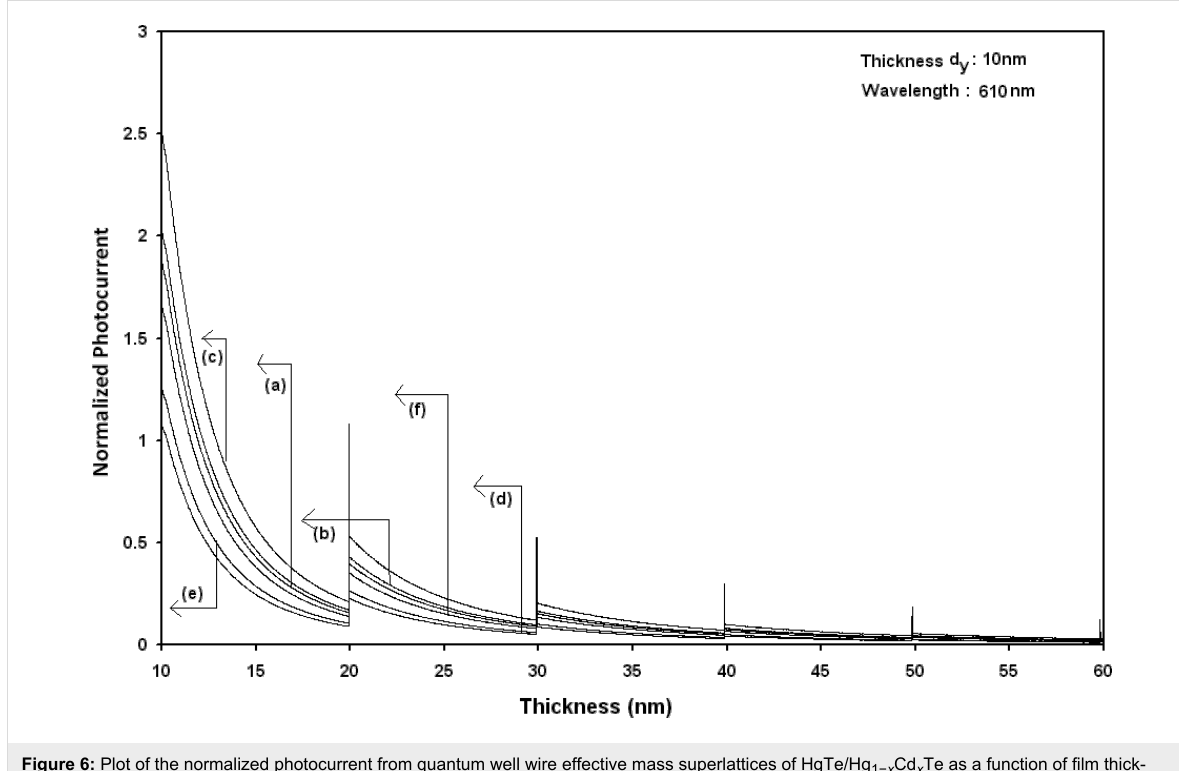
Figure 6: Plot of the normalized photocurrent from quantum well wire effective mass superlattices of HgTe/Hg 1 − x Cd x Te as a function of film thick- ness in which the curves (a), (b) and (c) represent the perturbed three and two band models of Kane and parabolic energy bands, respectively. The curves (d), (e) and (f) exhibit the corresponding plots of In x Ga 1 − x As/InP.